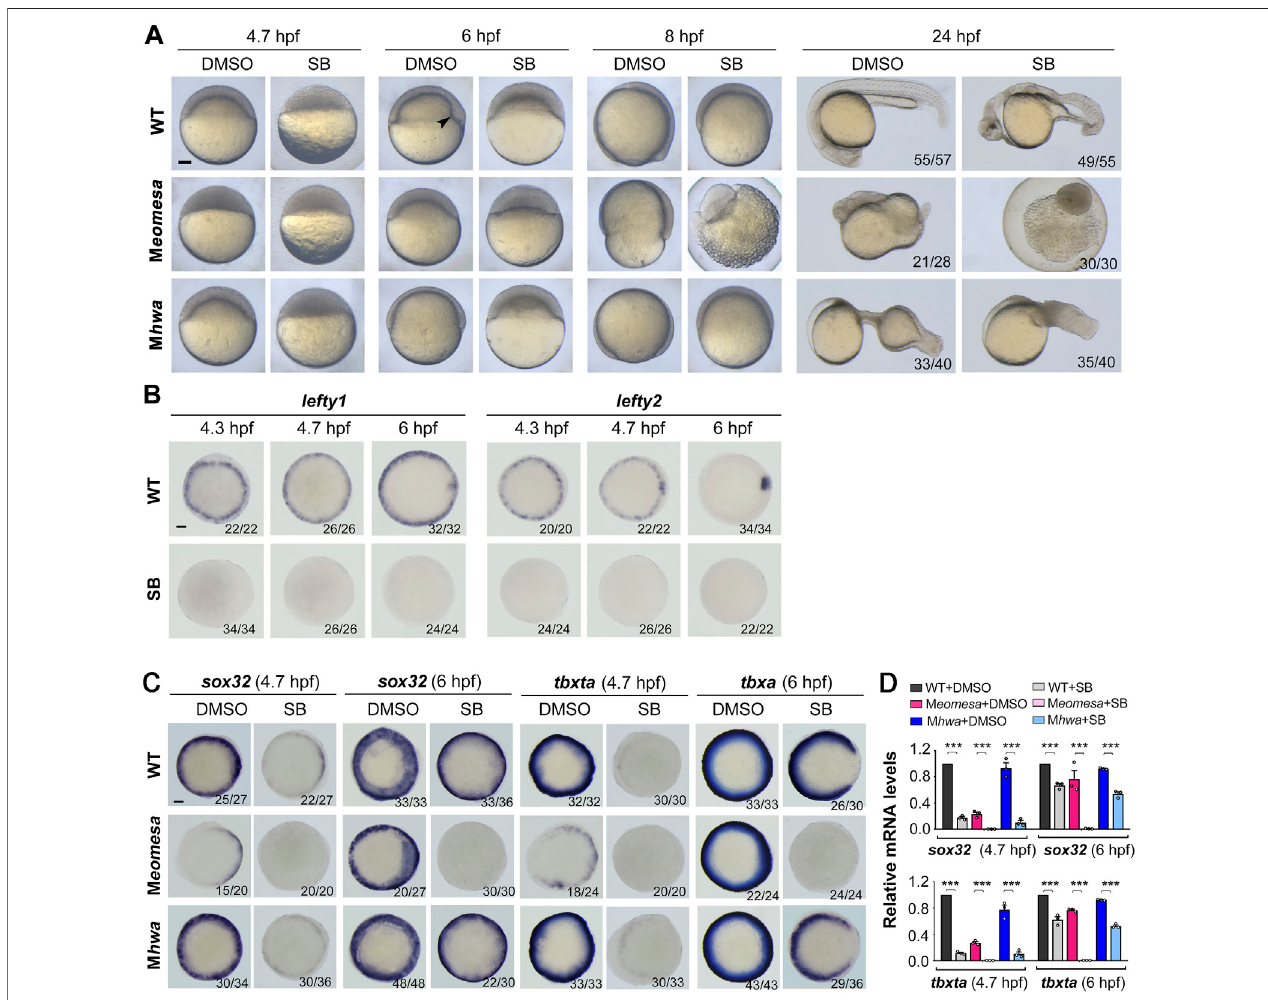
FIGURE 5 | Responses of M eomesa and M hwa mutants to Nodal signaling inhibition. One-cell stage embryos (10 min postfertilization) were incubated in Holfreter ’ s water with 1% DMSO (control) or 50 μ M SB431542 (SB, the Nodal signaling inhibitor), and harvested at 24 hpf for morphological observation (A) or for detection of marker gene expression by WISH (B,C) or qRT-PCR analysis (D) at indicated stages. Note that inhibition of Nodal signaling aggravated mesendodermal defects in both M eomesa and M hwa mutants (A) . Embryos were positioned laterally (A) or in animal-pole view with dorsal to the right (B,C) if the dorsal or tail was perceptible. The embryonic shield in WT embryo at the shield stage was indicated by an arrowhead. Scale bars, 100 μ m. The ratio of embryos with the representative pattern was indicated in the right bottom (B,C) . qRT-PCR analysis was performed using 15 embryos per sample, and the expression level was normalized to that of eif4g2a in WT embryos at the same stage. Error bars indicated S.D. based on three biological replicates (indicated by small circles). Statistically signi fi cant level: ***, p <